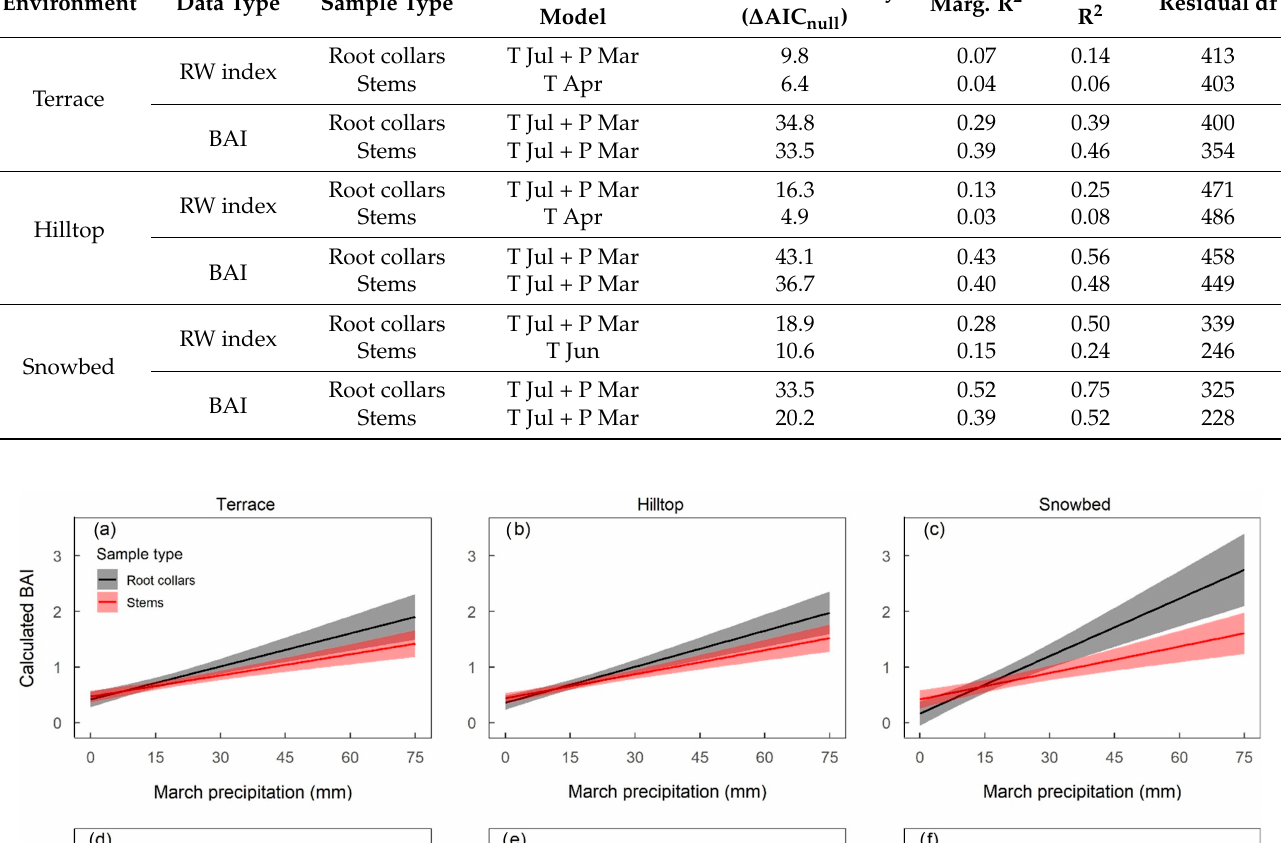
Table 1. Climate sensitivity values ( ∆ AIC null ), model fit statistics (R 2 ), and residual degree of freedom (residual df) for the best climatic variables explaining the RW index (detrended by mean-centering) and calculated BAI of Betula glandulosa root collars and stems over the 1947–2009 period.